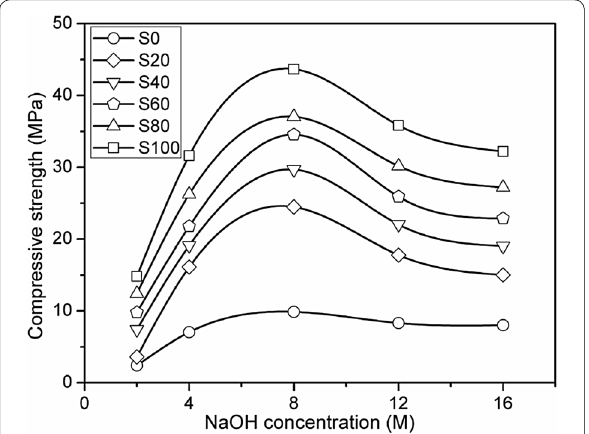
Fig. 5 Variation in compressive strength with NaOH